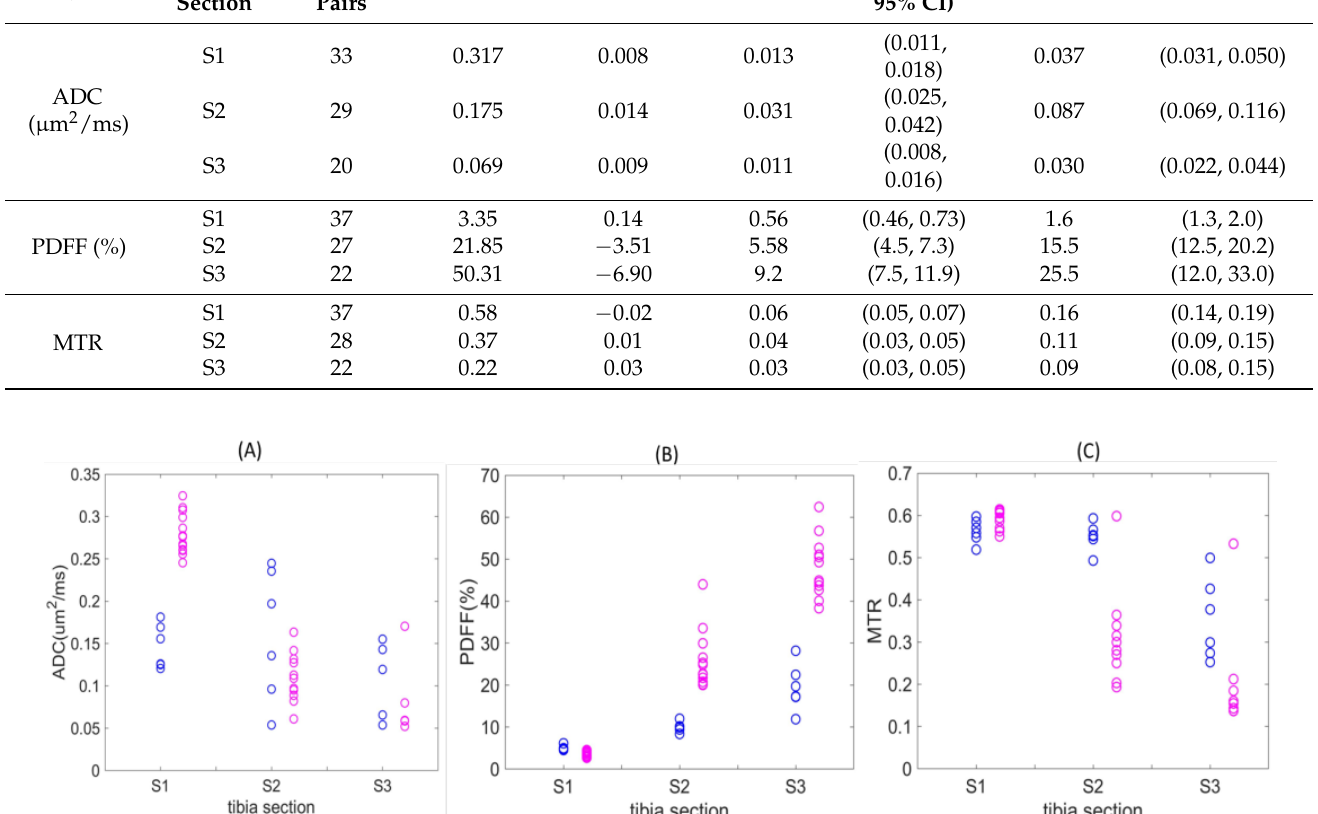
Figure 3. QIB values at 5–6 weeks post-ablation for individual diseased mice (magenta) and wild- type (non-ablated) mice (blue, average of 2–5 longitudinal measurements) across the defined tibia bone-marrow sections. Plots for ADC ( A ), PDFF ( B ), and MTR ( C ). However, MTR measures revealed mostly lower values for diseased bone marrow in Sections S2 and S3 as compared to WT mice (Figure 3C). Section S2 and S3 ADC values for WT mice displayed high variability, and only a smaller number of confident measurements was possible for diseased mice in S3 (5 of 13; Table 2). For PDFF and MTR of wild-type